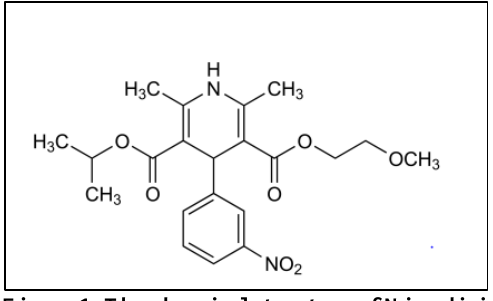
Figure 1. The chemical structure of Nimodipine NMD is a yellow crystalline powder with a melting point of 125℃, pKa 5.4, and a partition coefficient (log p) 3.05. It has a molecular formula and weight of C 21 H 26 N 2 O 7 and 418.4 gm/mol, respectively (8) .